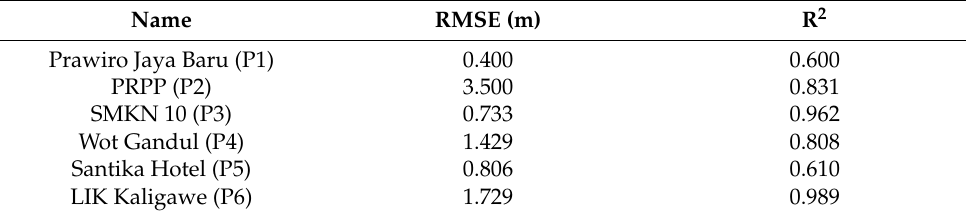
Table 3. Total RMSE and R 2 for the transient flow